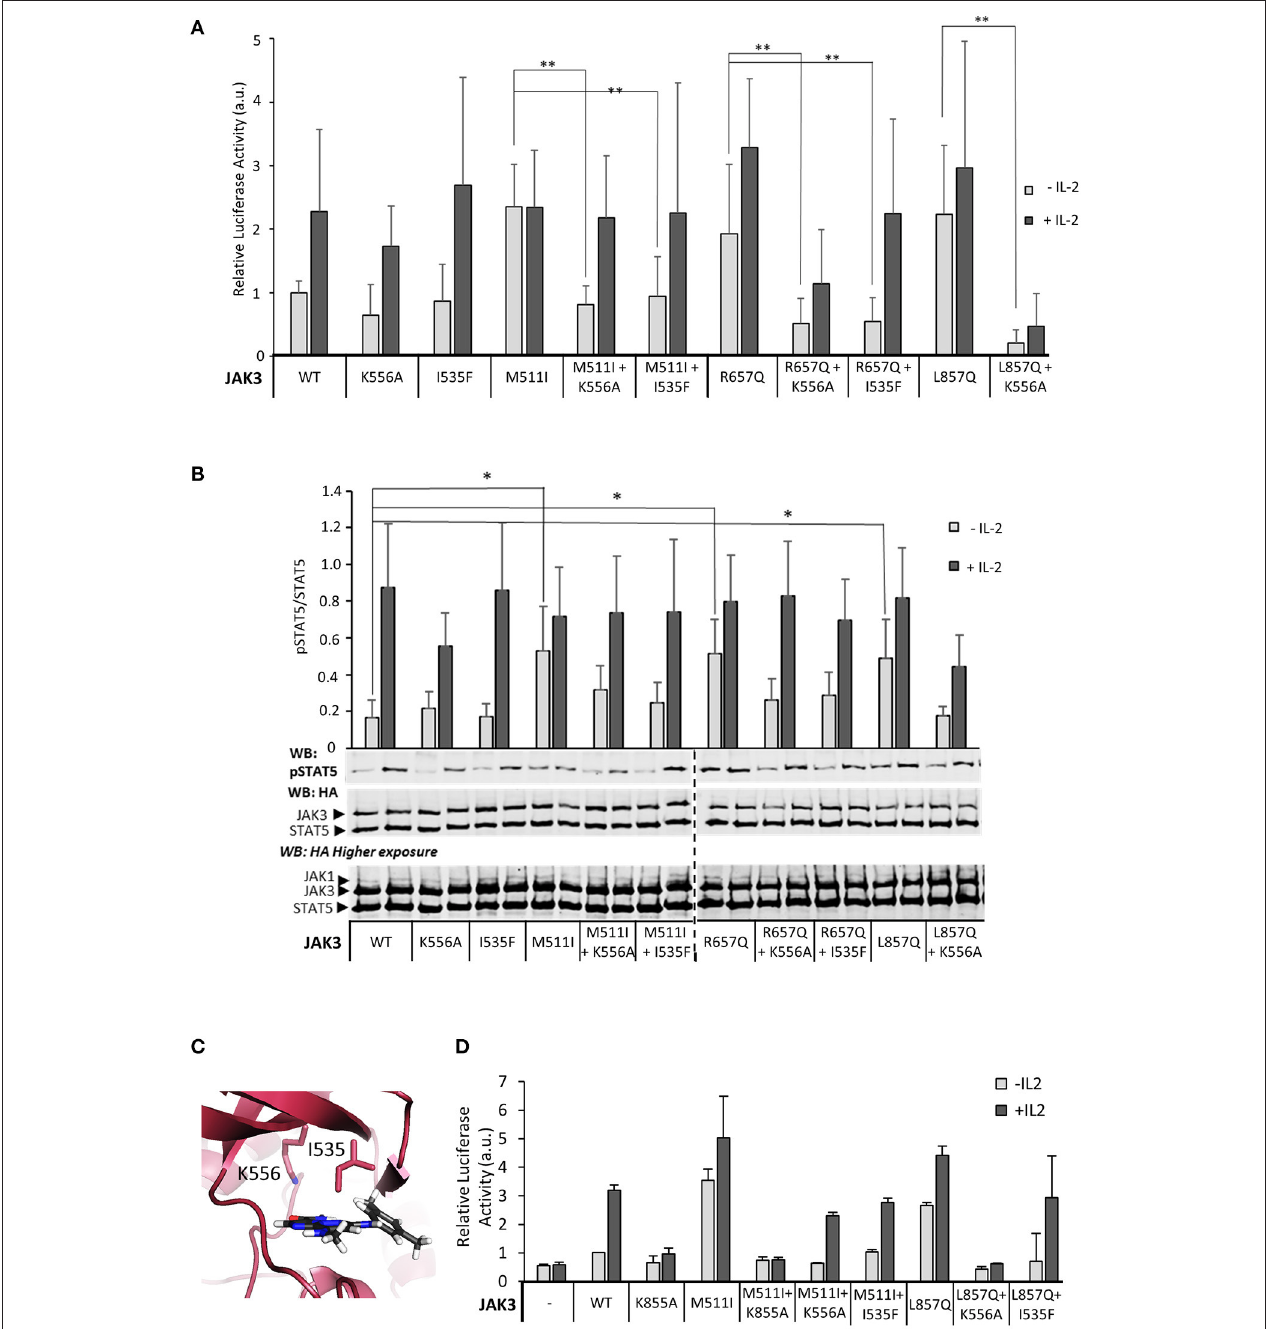
FIGURE 4 | Inhibition of ATP binding to the pseudokinase domain of JAK3 reverts pathogenic, ligand-independent JAK3 signaling, while retaining cytokine-responsiveness. (A) JAK3 JH2 ATP-binding site mutations suppress activating JAK3 mutants. Luciferase assay was performed in U4C γβ cells transfected with JAK1 and the indicated JAK3 mutants using β -galactosidase as a transfection control. The results are from three independent experiment, each having triplicate samples ( n = 9, expect for K556A n = 7). Similar results were obtained with pRL-TK control. Data is normalized to the basal wild-type sample, errors are presented as SD. Statistical analysis of the activating mutations, and their corresponding double mutants were done with two-tailed t -test using unequal variances. ** p < 0.001. (B) Representative Western blot of the transiently transfected U4C γβ cell lysates showing the pSTAT5 signal. HA-tagged STAT5 was co-transfected with HA-tagged JAK1 and JAK3 and the lysates were blotted with anti-HA and anti-pSTAT5. Lower panel: Quantitative pSTAT5/STAT5 signal analysis. Activation of JAK3 signaling by M511I, R657Q and L857Q is significant (* p < 0.05). Data is average of five experiments. (C) The localization of the mutated JAK3 JH2 ATP-binding residues. Homology model of JAK3 JH2 (based on TYK2 structure from PDB, code: 4OLI), ATP is shown in gray. (D) Kinase-inactive JAK3 K855A abolishes IL-2 signaling in the presence of the activating JAK3 mutation M511I. Luciferase assay with STAT5-responsive promoter and with pRL-TK control.